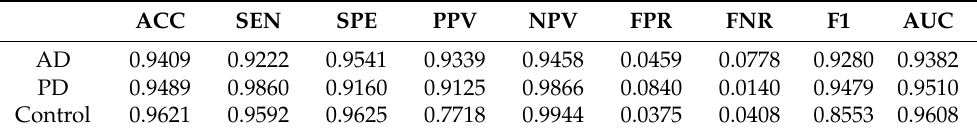
Table 3. Performance metrics of AFF-VGG19 on the brain disorders dataset. AD stands for Alzheimer’s disease and PD for Parkinson’s